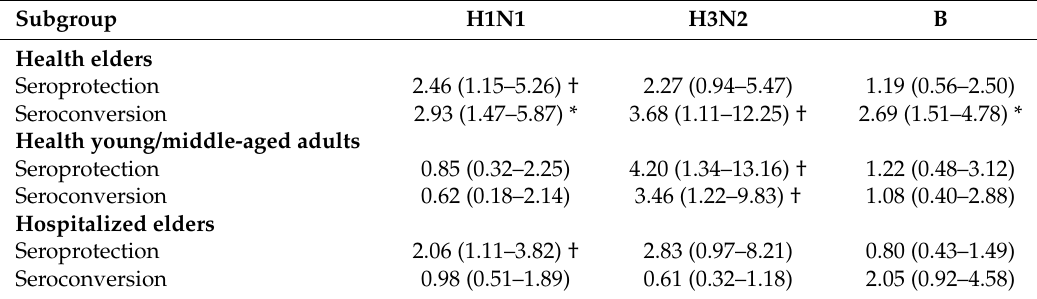
Figure 6. Forest plots of subgroup analysis by participants of seroconversion rate of H1N1 and H3N2 strains. ( a ) Forest plot of subgroup analysis by health status of participants of seroconversion rate for influenza H1N1 strain; ( b ) Forest plot of subgroup analysis by health status of participants of seroconversion rate for influenza H3N2 strain. The bold data represents total participants of all included studies and the Odds ratio (OR) between the probiotics/prebiotics group and the placebo group. The diamond stands for the pooled OR. Weights are from random-effects model. CI: confidence interval. Table 2. Subgroup analysis of odds ratio of seroprotection and seroconversion rate for different influenza strains based on health status of participants.